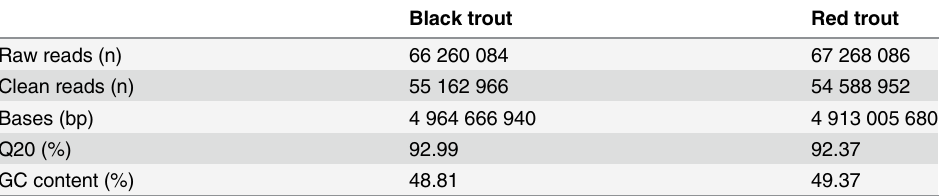
Table 1. Summary statistics of the paired-end Illumina sequencing of two common coral trout